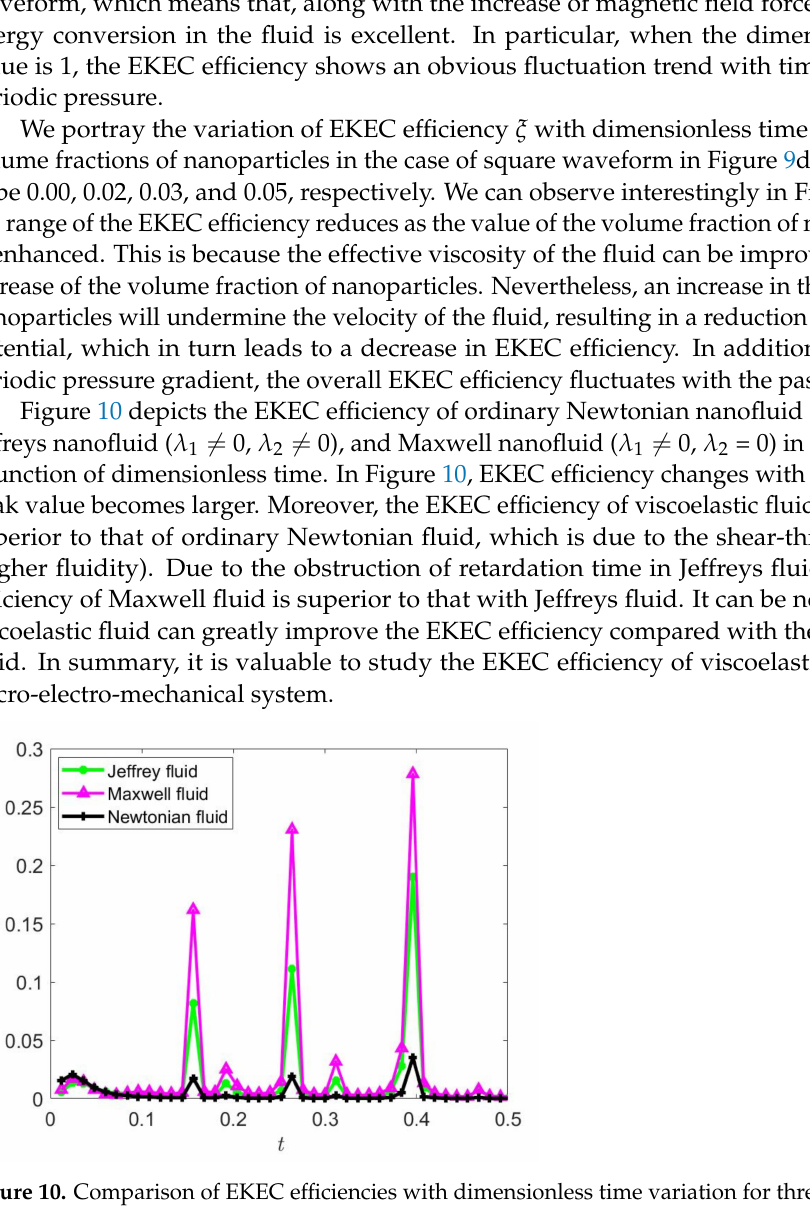
Figure 10. Comparison of EKEC efficiencies with dimensionless time variation for three fluids in the condition of square waves at ϕ = 2%, ω = 2, Ha = 2, K =